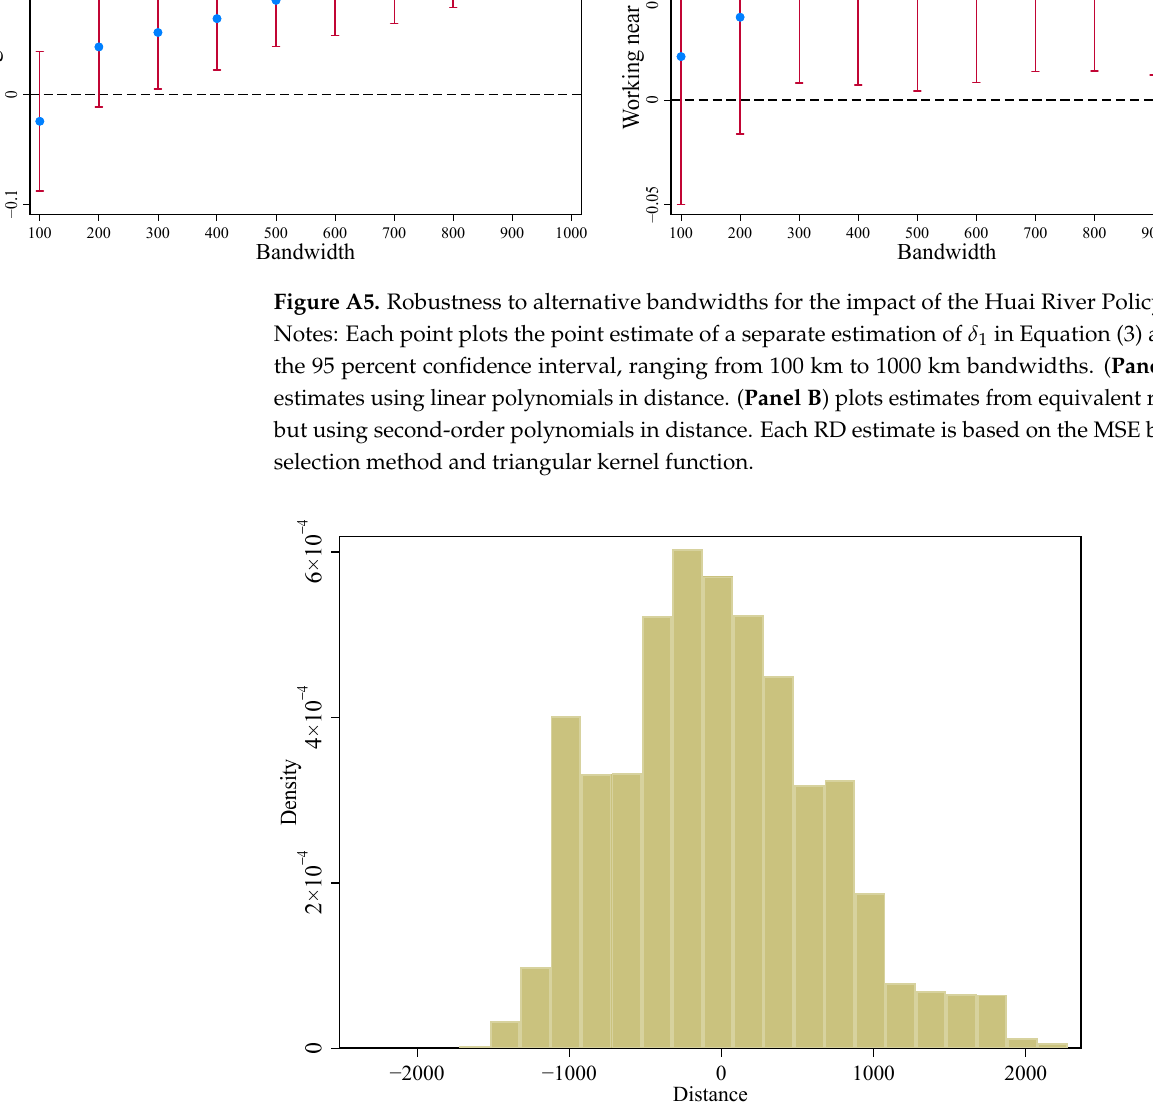
Figure A6. Distributions of distances of counties from the Huai River.